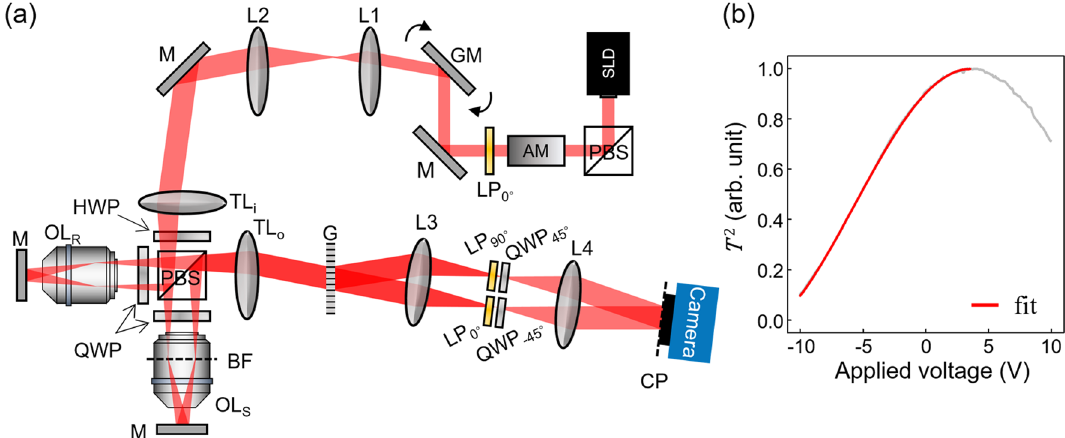
Figure 1. Experimental setup and amplitude modulation. ( a ) Schematic diagram of the experimental setup. AM: amplitude modulator; M: mirror; L1–L4: lenses; GM: galvano mirror; LP 0 ◦ : output polarizer; TL i and TL o : tube lenses for input and output ports; HWP: half-wave plate; PBS: polarizing beam splitter; QWP: quarter- wave plate; OL R and OL S : objective lenses for reference and sample arms; BF: back focal plane of objectives; G: diffraction grating; LP α : linear polarizer with α -deg rotation angle. ( b ) Output intensity response of the AM to the driving